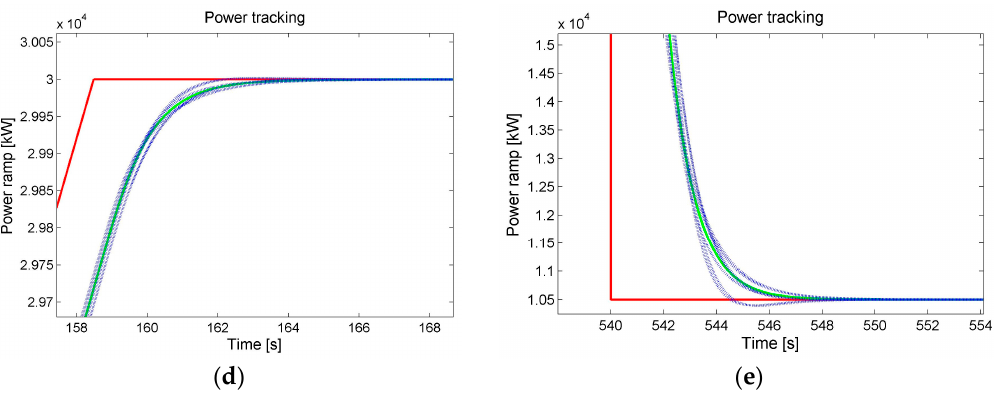
Figure 18. Closed-loop power reference tracking with random samples of the uncertain system: ( a ) Complete view; ( b ) Disturbance rejection in the initial stage; ( c ) Ramp command start; ( d ) Steady-state at 30 MW; ( e ) Power profile in the final stage.